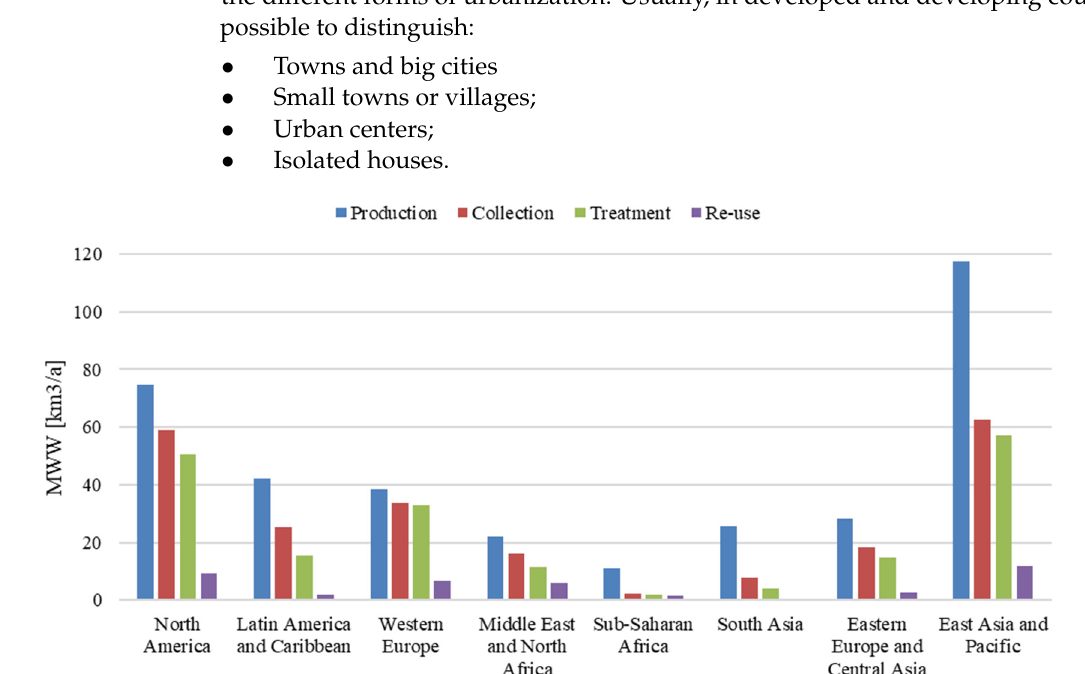
Figure 4. MWW production, collection, treatment, and reuse by region.